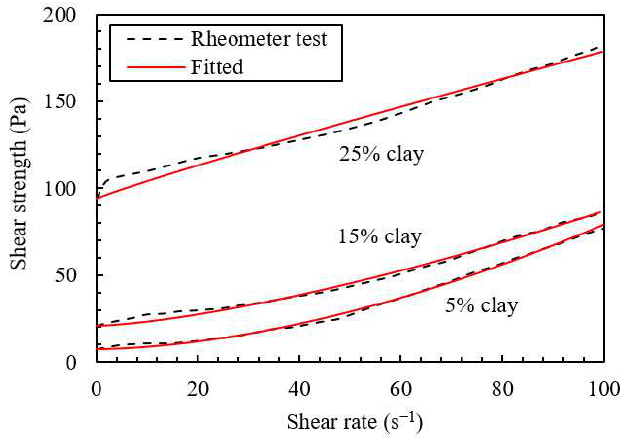
Figure 4. Shear strengths of slurries with different clay